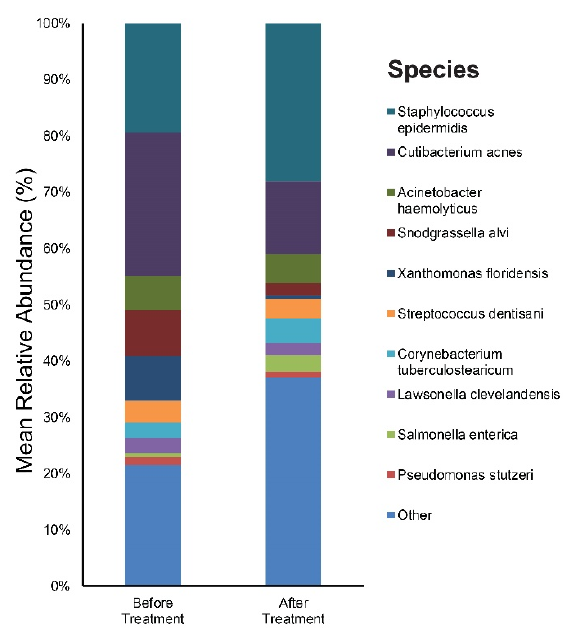
Figure 2. Bar graph on skin microbiota in acne patients before and after six weeks of doxycycline.